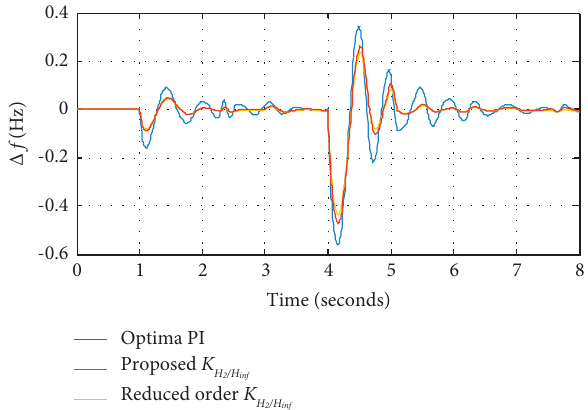
Figure 17: Comparison of the frequency response of the studied MG system equipped with the proposed robust VI, its reduced order form, and proposed intelligent self-tuning PI proposed in [37] under power fuctuations in the scenario